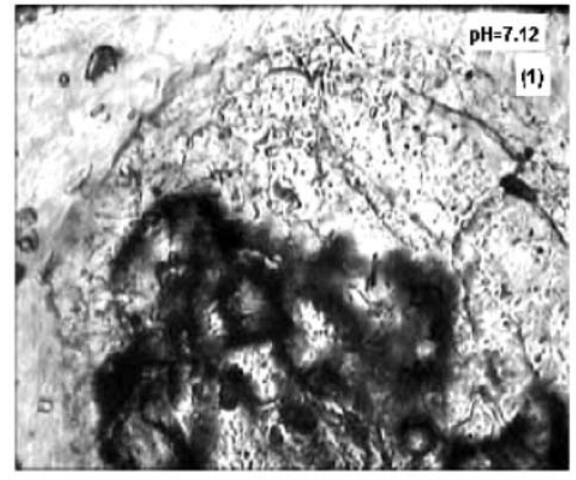
Fig. 11 Microscopic image of solid PEG-rich phase in the presence of NH 3 , pH=7.12, after metal species extraction (Cd i = 57.05 µ g/mL, [I − ] add = 0.06 mol/L: (1) detail at